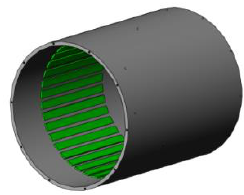
Figure 9. Assembly drawing of magnetic poles and rotor core.